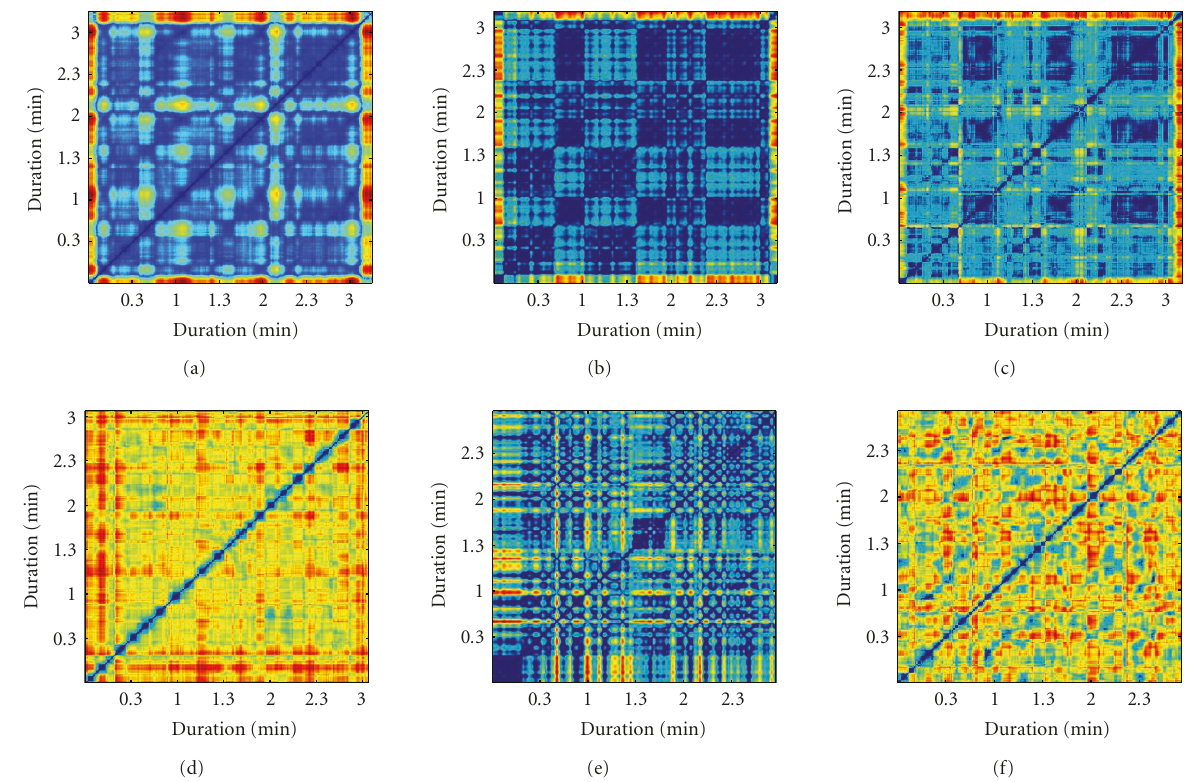
Figure 4: L 2 self-similarity for the rhythmogram (left), timbregram (middle), and chromagram (right), of Whenever, Wherever (top) and All of me